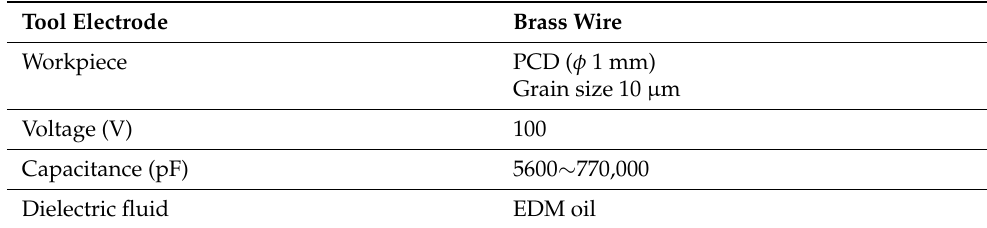
Figure 1. Microtool fabrication: ( a ) WEDG system and ( b ) fabricated microtool. Table 1. EDM conditions.